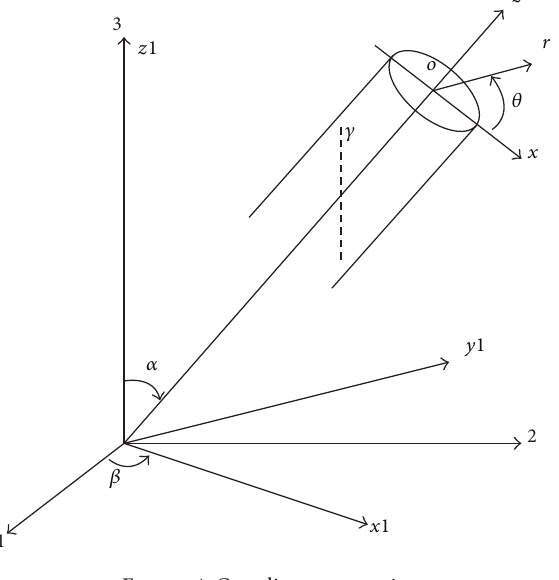
Figure 4: Coordinate conversion.